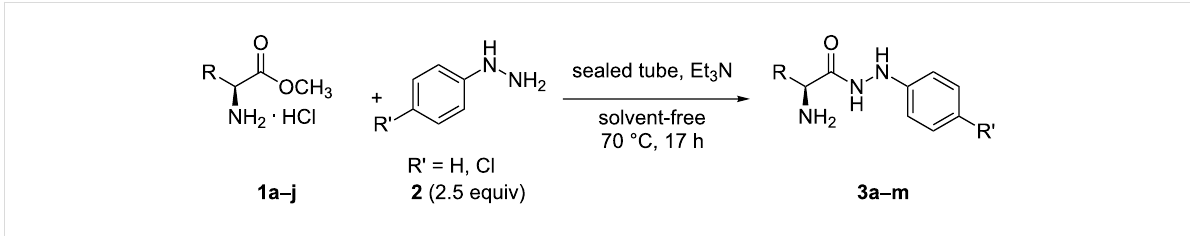
Scheme 2: Synthesis of the starting (L)- α -amino acid phenylhydrazides and 4-chlorophenylhydrazides 3a – m under solvent-free conditions.